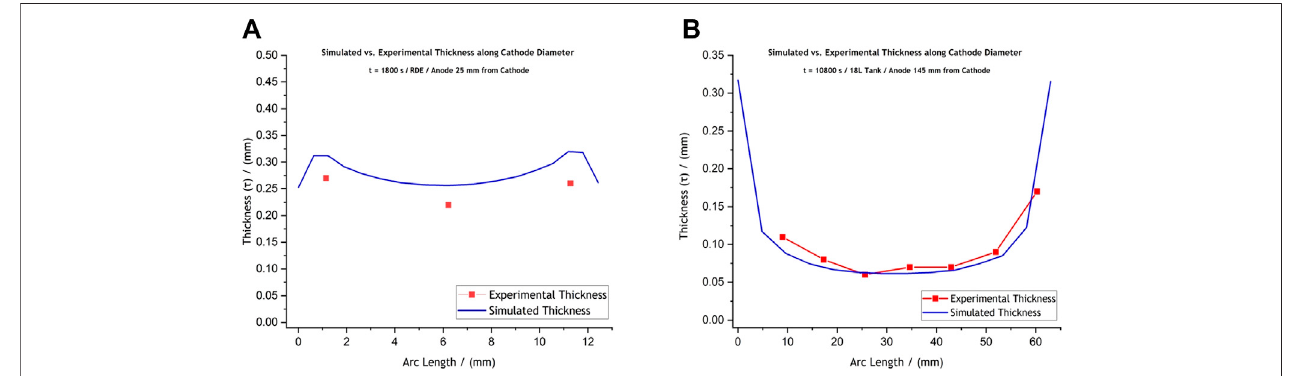
FIGURE 4 | Comparative graphs of the experimentally achieved and the simulated thickness pro fi les for (A) the laboratory-scale RDE setup and (B) the prototype electroformingreactorsetup.TheRDEdepositwasproducedat − 5 Vand − 0.565 A,for1,800 s,whilethereactordepositwasformedat − 2.5 Vand − 1 A,for10,800 s. These conditions allowed, in both cases, for thick enough deposits to be sectioned, mounted in resin, and measured under the microscope without